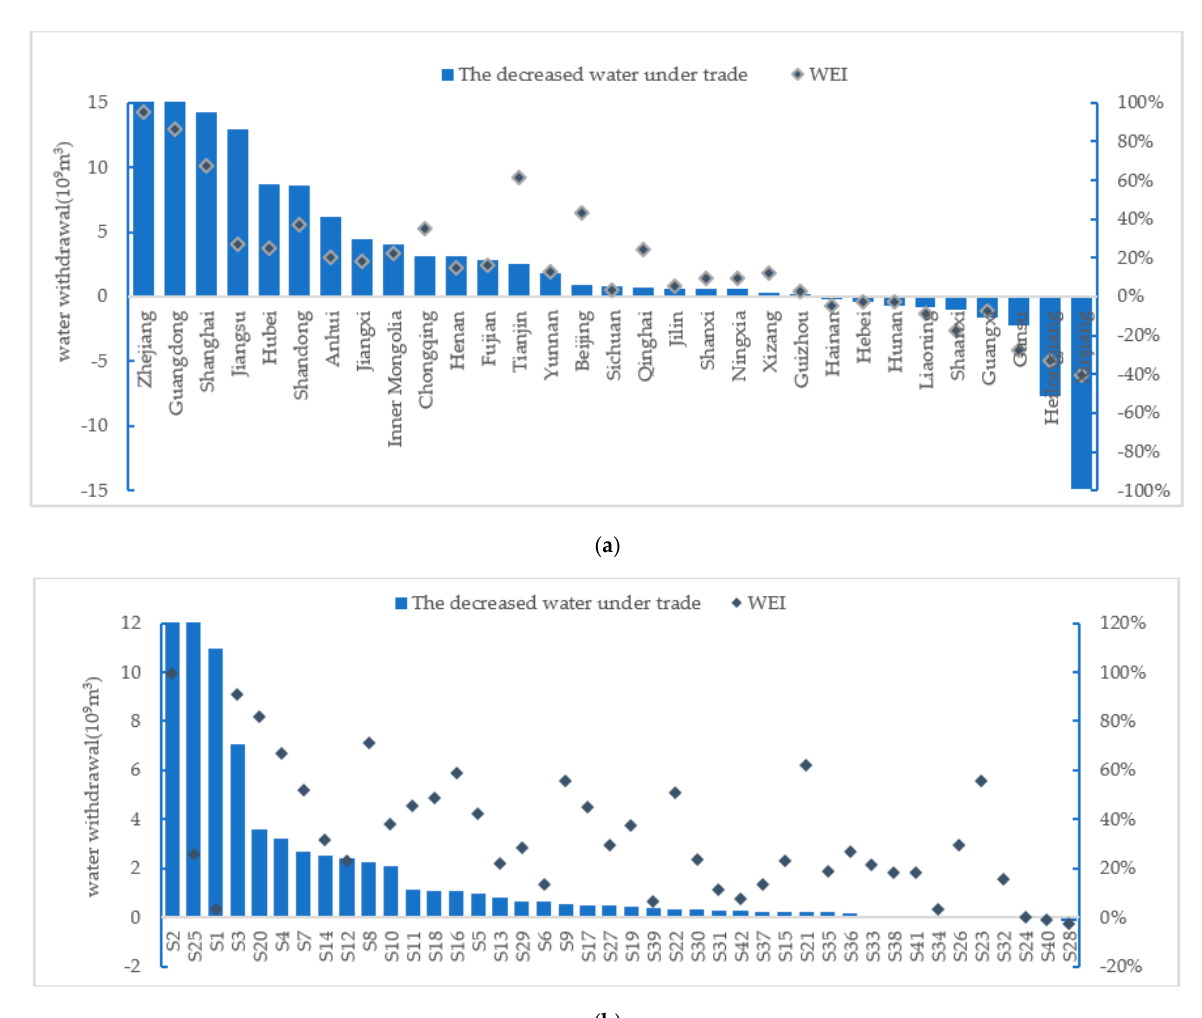
Figure 4. Water-saving efficiency of virtual water trade by province ( a ) and by sector ( b ). Note: The sector classification is listed in Table S1 presented in Supplementary Material. The decreased water under trade in Zhejiang and Guangdong is 223.21 × 10 9 m 3 and 174.70 × 10 9 m 3 , respectively; the decreased water under trade in S2 and S25 is 378.61 × 10 9 m 3 and 19.40 × 10 9 m 3 , respectively.